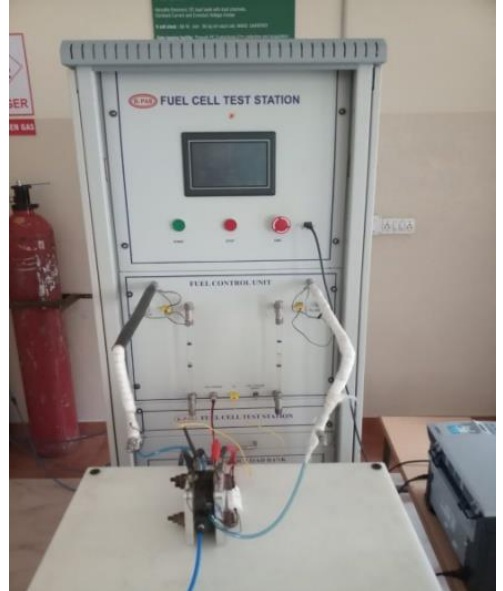
Figure 4. K-PAS fuel cell test station.